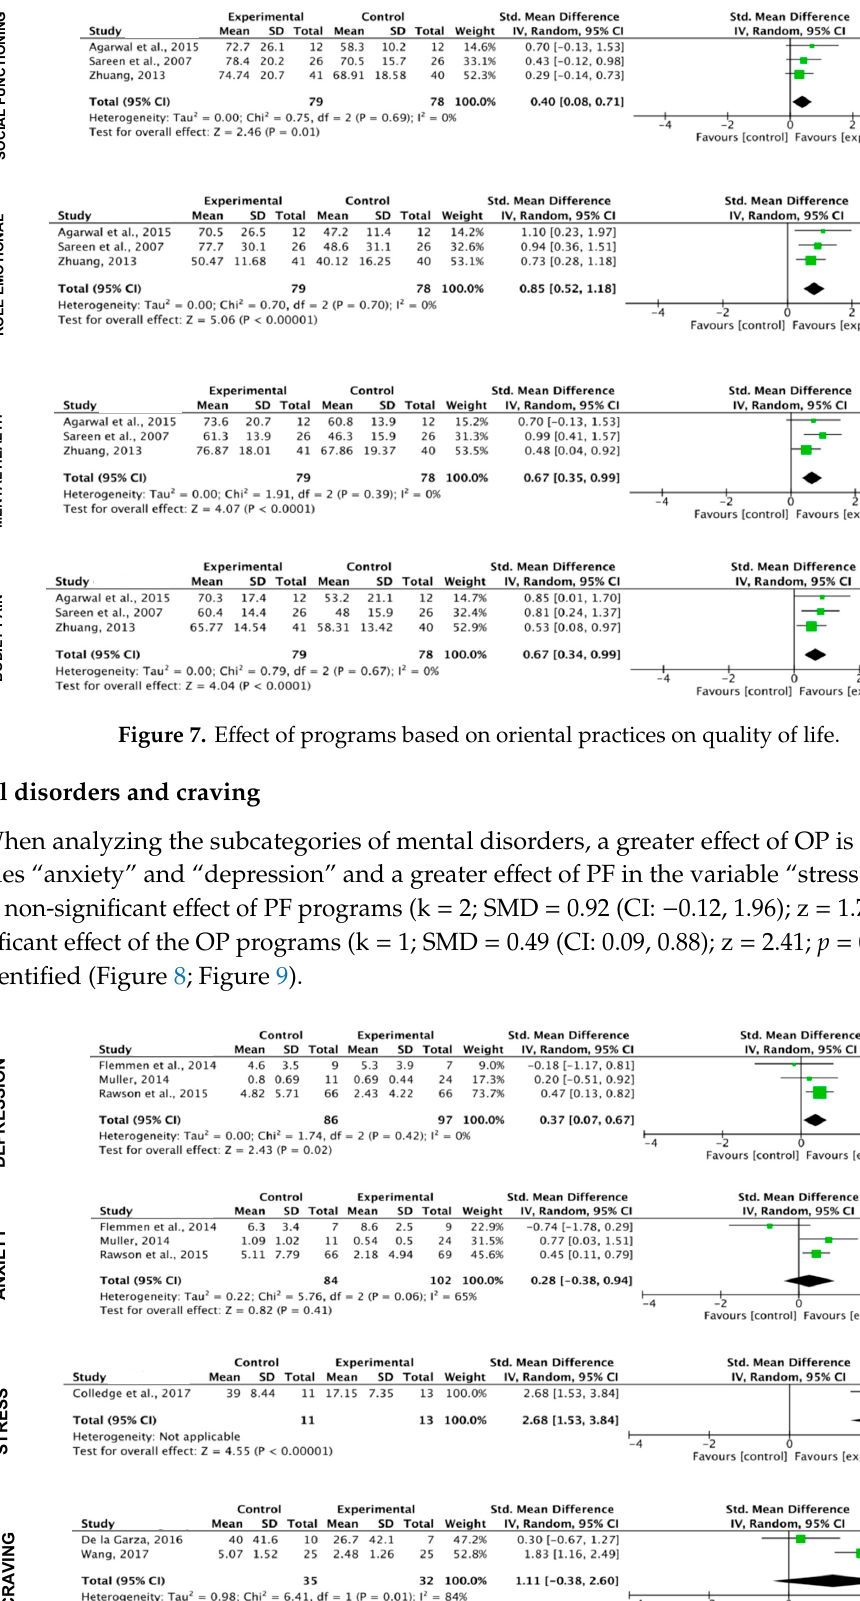
Figure 9. Effect of oriental practices on mental disorders and craving. 4. Discussion